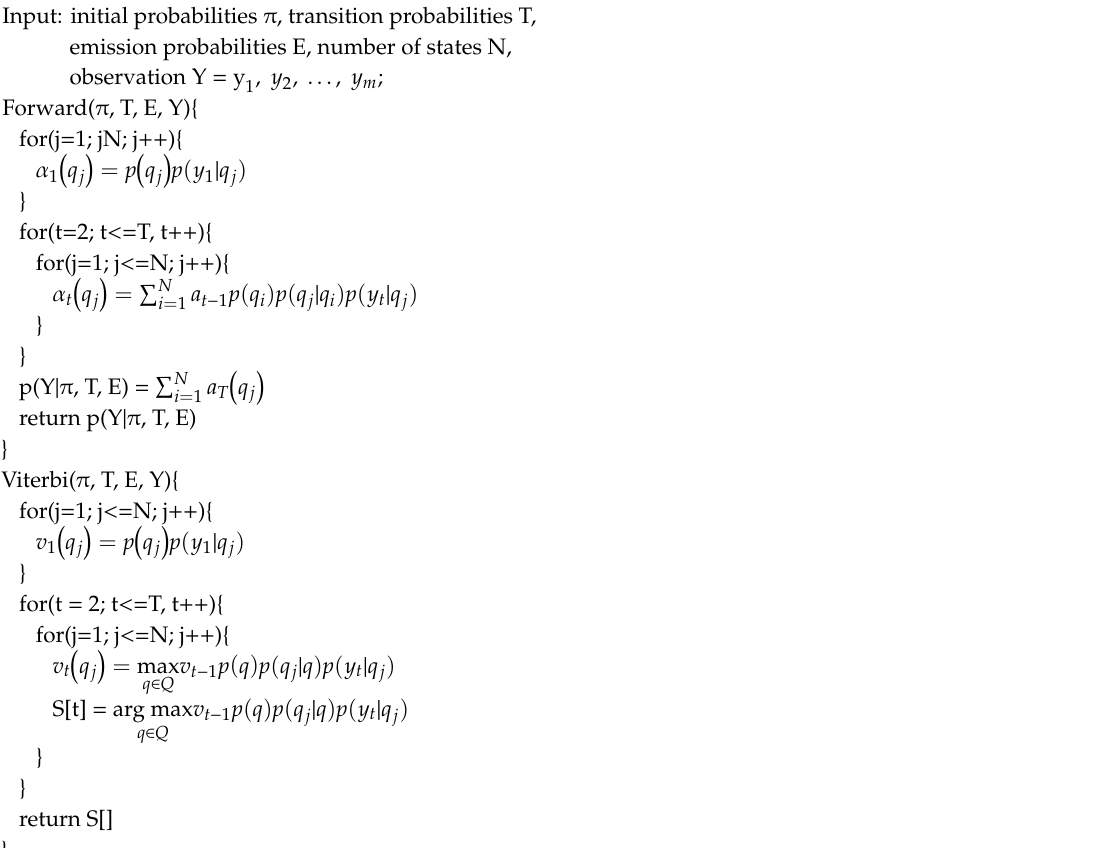
Algorithm 1. Computation of observed values and array of